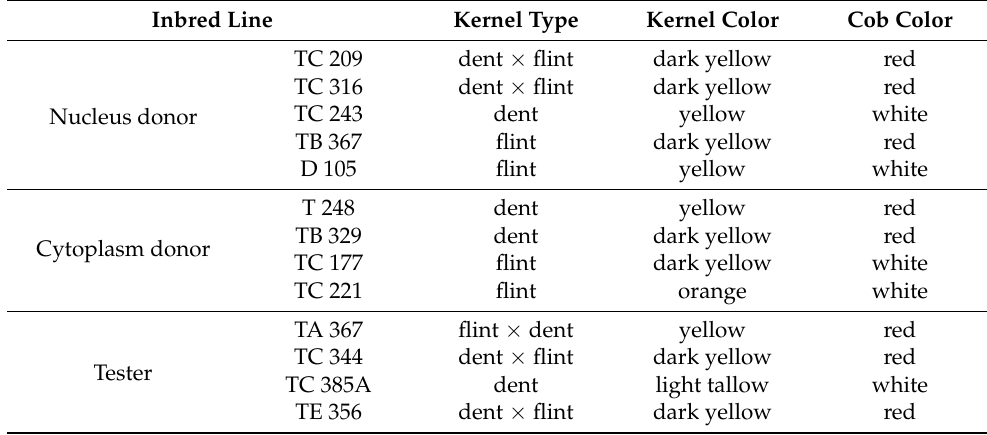
Table 12. Cob traits of the inbred lines studied. Inbred